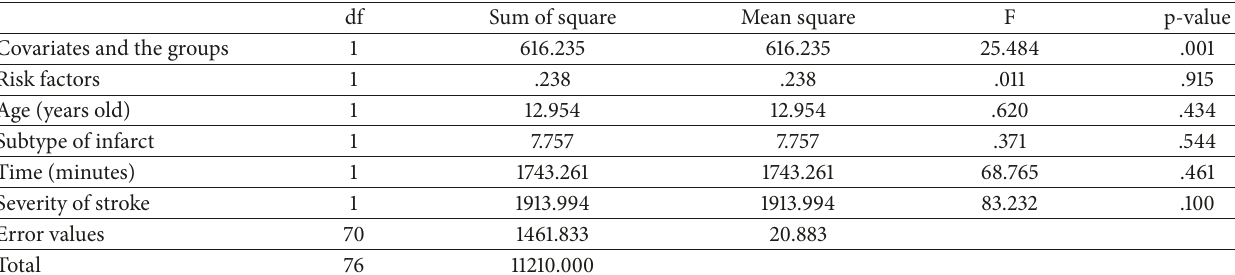
Table 5: Comparison of mean NIHSS at 24 hours after intravenous rt-PA between experimental group and control group by ANCOVA test [control variables which are not related to the experimental group but affected covariates include age, risk factors, subtype of infarct, severity of stroke, and time from stroke symptom onset to hospital